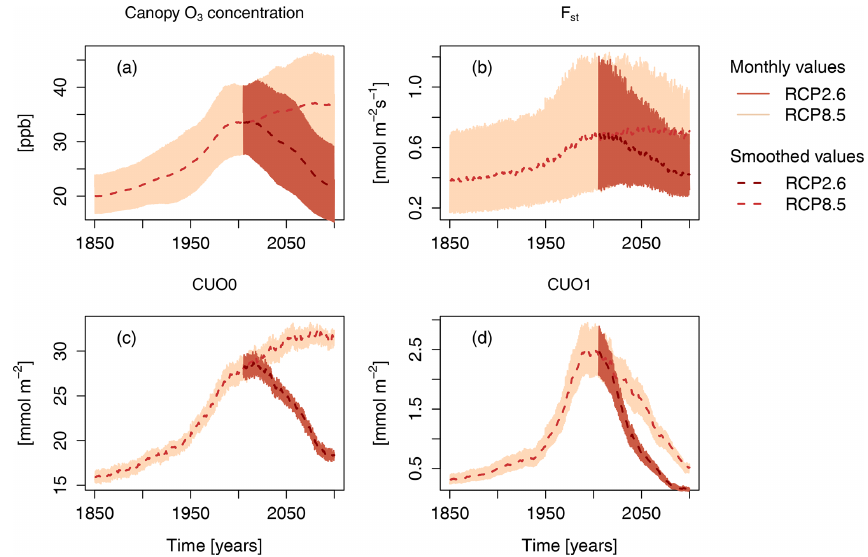
Figure 3. Simulated canopy O 3 concentration, O 3 uptake ( F st ), cumulative O 3 uptake without a flux threshold (CUO0), and cumulative O 3 uptake above a flux threshold of 1nmolm − 2 s − 1 (CUO1) of the factorial run S5 (all forcing variables are simulated transient). Displayed are monthly values and smoothed values, where the effect of the seasonal cycle is smoothed by the application of a moving average of 12